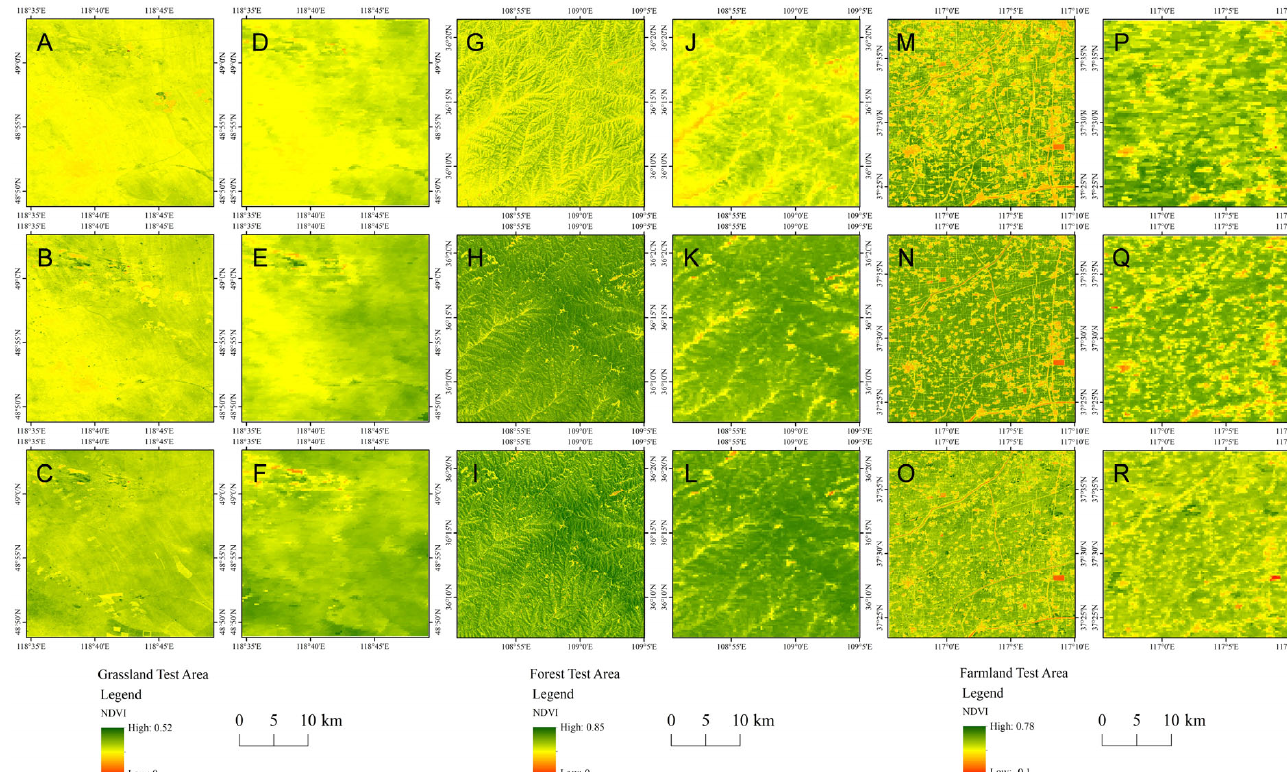
Figure 2. NDVI data for the three test areas. ( A – F ) are grassland test areas: ( A ), LC09_124026_20220520;